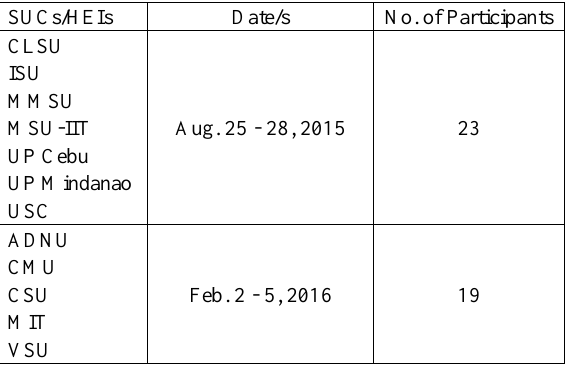
Table 2. Process Trainings conducted by PHD